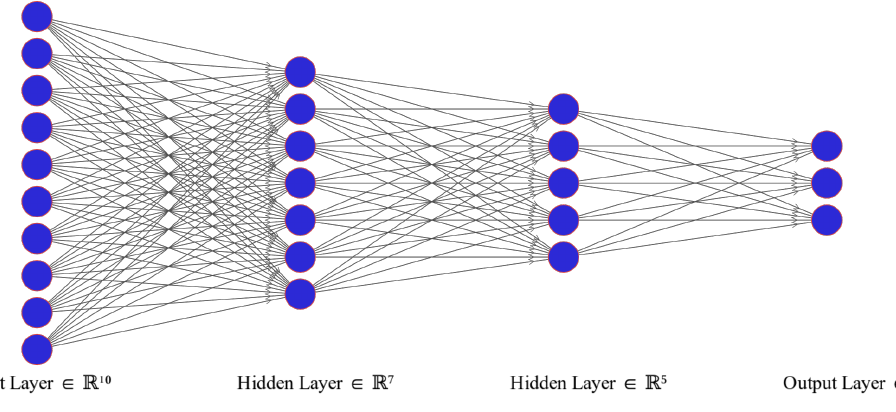
Figure 2. MLP model architecture.